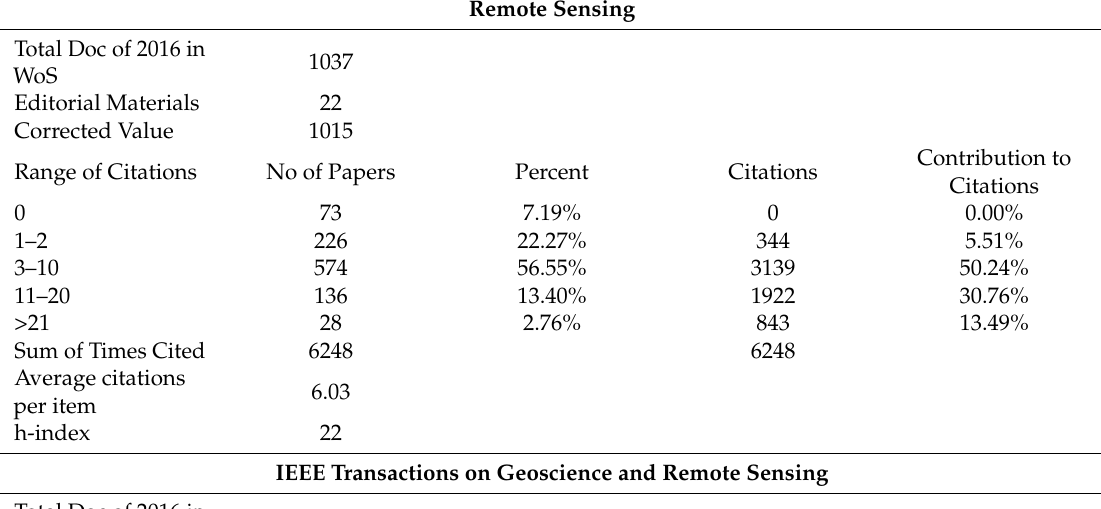
Table 15. Comparison with two of the best remote sensing journals for the year